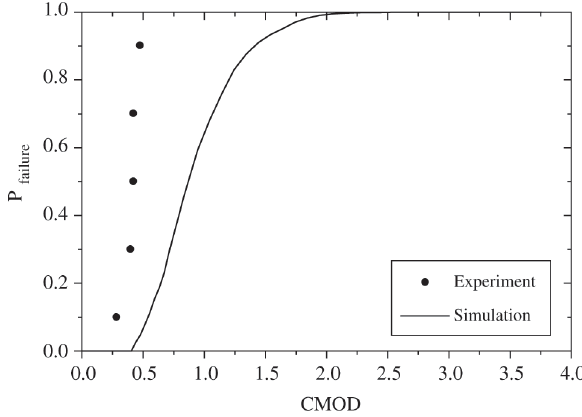
Figure 5. F32-T1: Calculated value for the J experimental J- ∆ a curve (CTJ20